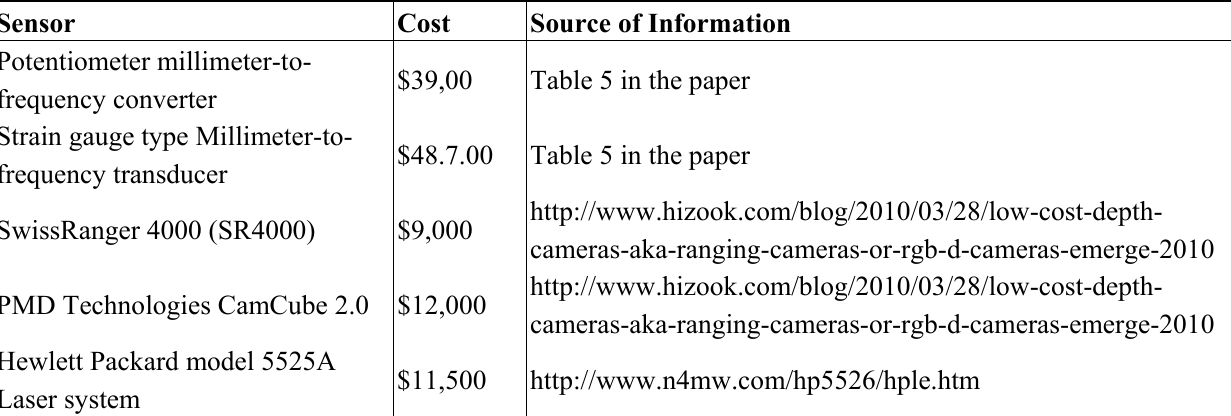
Table 6. Cost comparison with some existing position